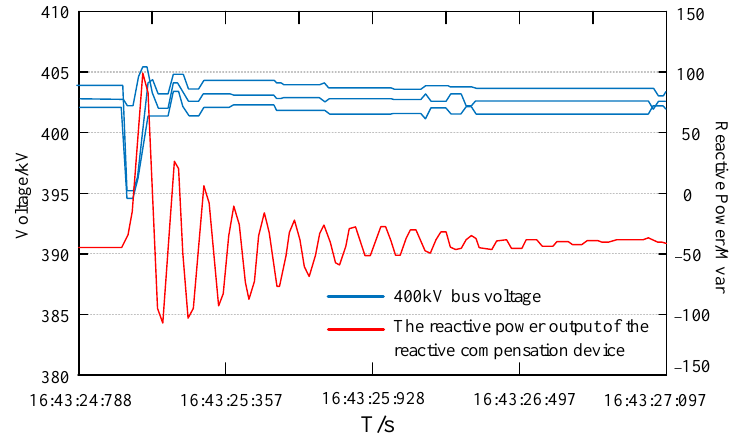
Figure 3. Response of Hornsea wind farm to voltage drop of 2%.